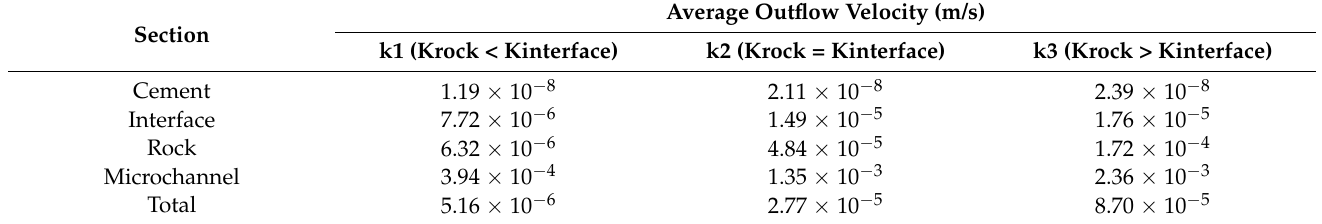
Table 14. Average outflow velocity through a cement–rock sample with microchannels and variable rock